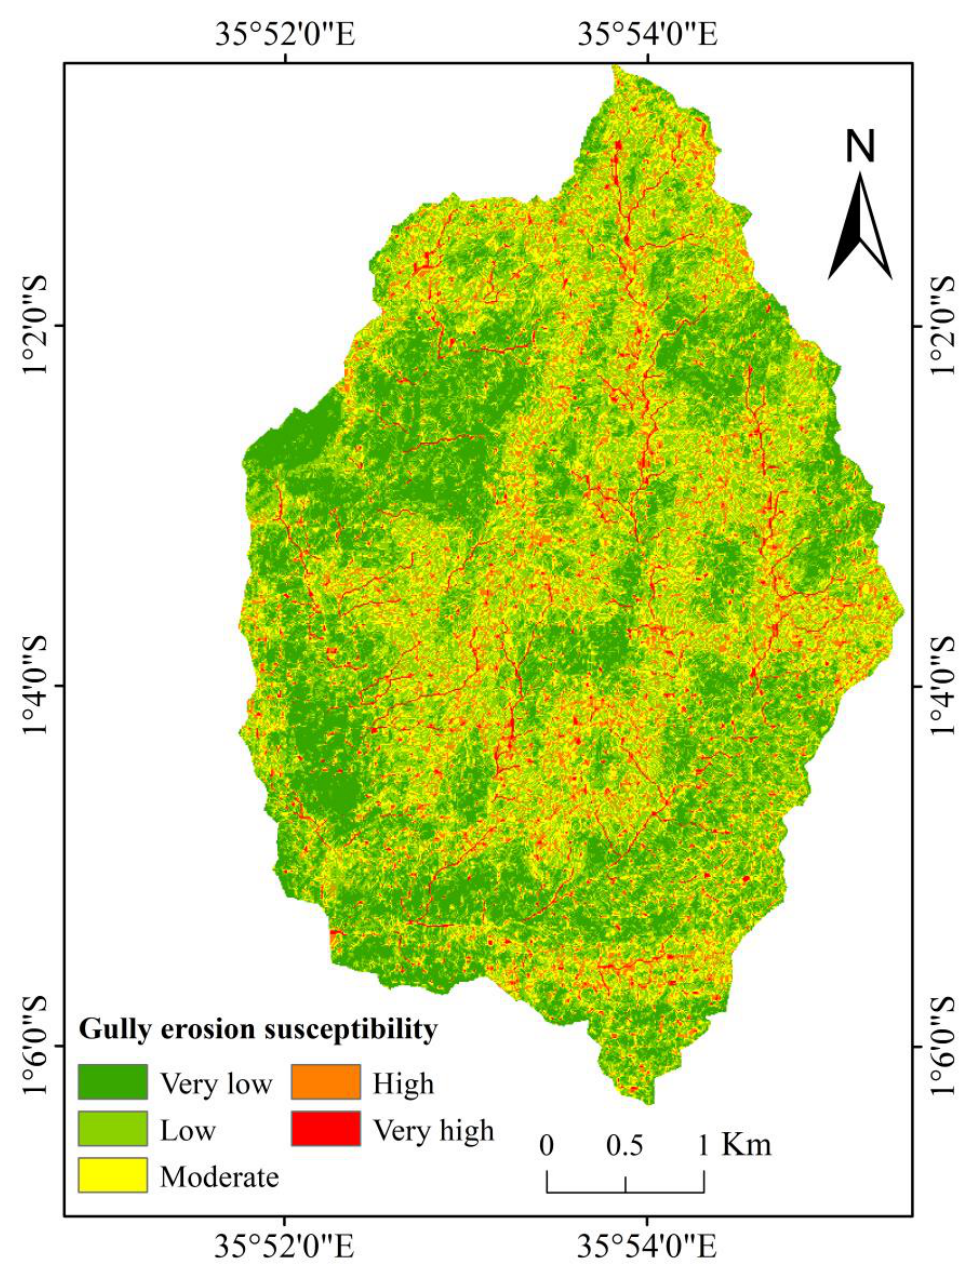
Figure 7. Map of gully erosion susceptibility of Kakia-Esamburmbur catchment using WoE.